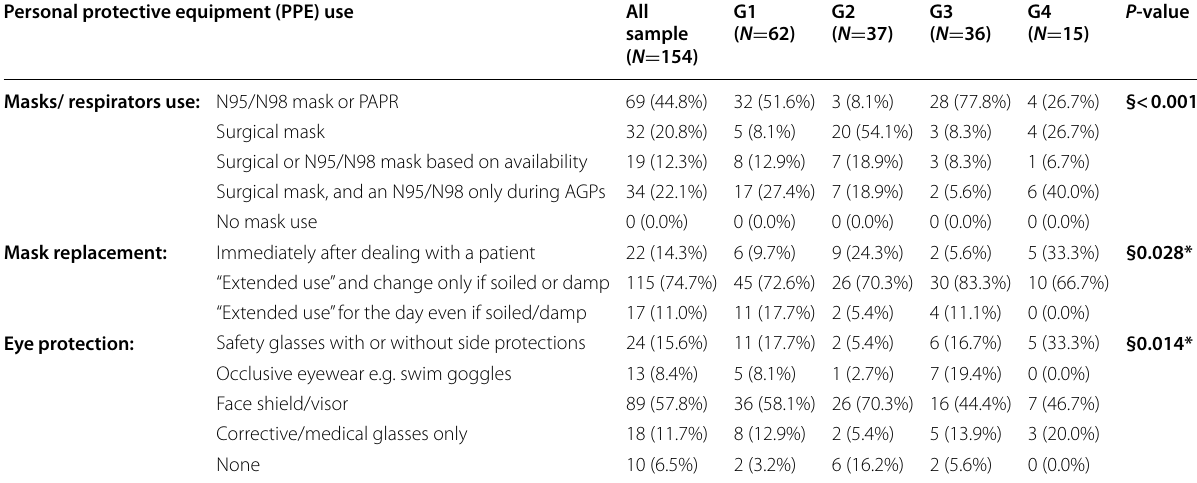
G1 (Western European), G2 (Middle Eastern), G3 (Latin American), G4 (Eastern European) countries’ participants §Fisher’s Exact test.